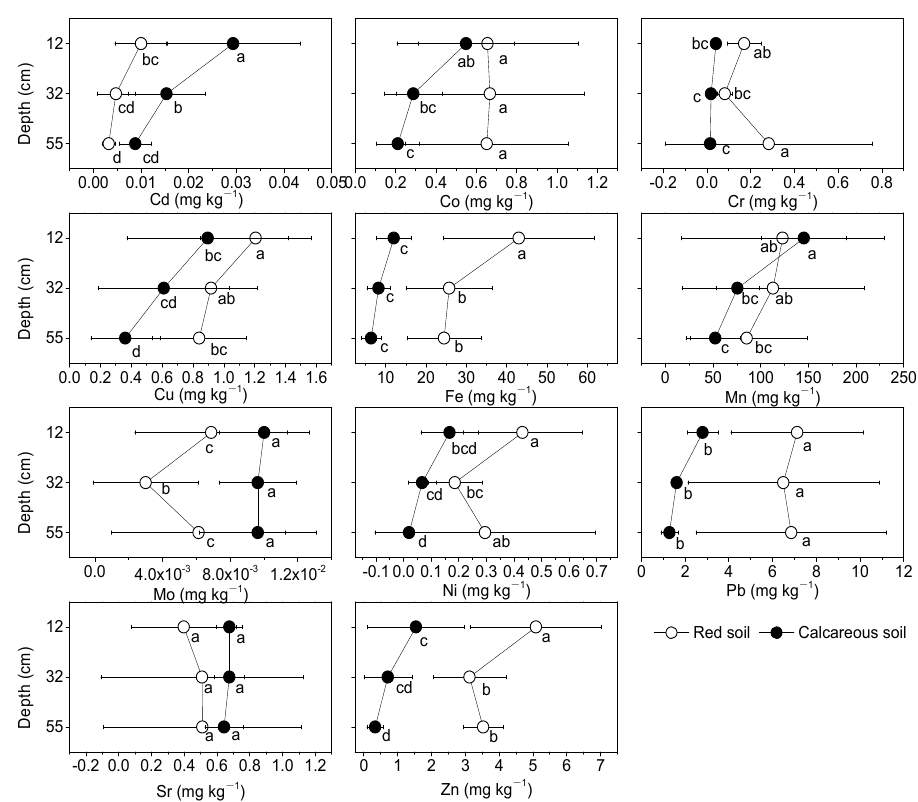
Figure 2. The distribution of the available content (C A ) of heavy metals in the soil profile. Identical lowercase letters indicate the same as Figure 1.